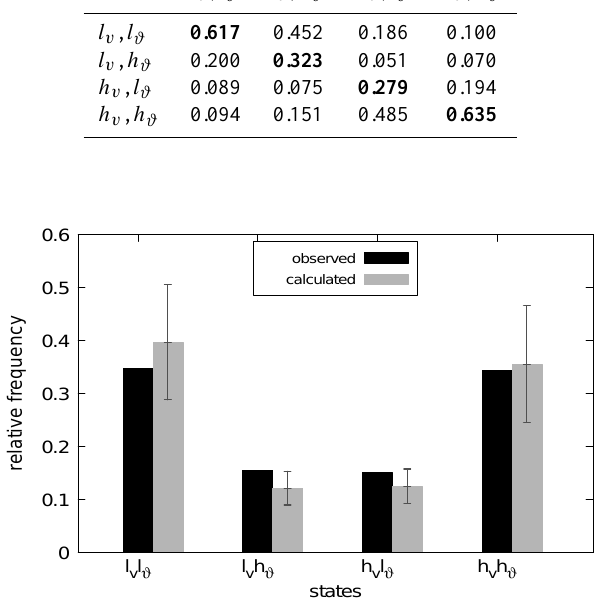
Fig. 6. Histogram of the observed ( b π j ) and calculated ( π j ) relative frequencies of the states. The errorbars (2 σ ) have been estimated by a resampling technique.